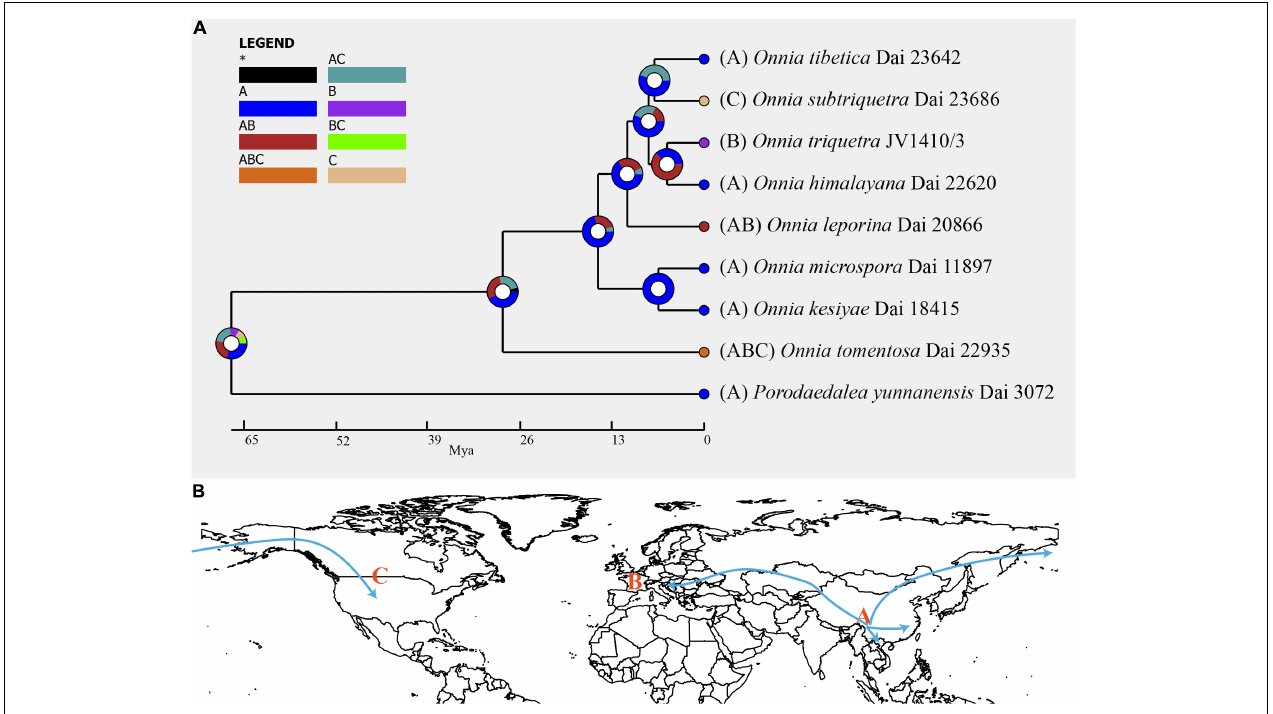
FIGURE 3 | (A) Ancestral state reconstruction and divergence time estimation of Onnia using a dataset containing ITS, LSU rDNA, rpb1 , rpb2, and tef1 α sequences. A pie chart at each node indicates the possible ancestral distributions inferred from dispersal-extinction-cladogenesis (DEC) analysis implemented in RASP. A black asterisk represents other ancestral ranges. (B) Possible dispersal routes of Onnia in the Northern hemisphere. Regions are labeled as follows: (A) Asia, (B) Europe, (C) North America, (AB) Asia and Europe, (AC) Asia and North America, (BC) Europe and North America, and (ABC) Asia, Europe, and North America.